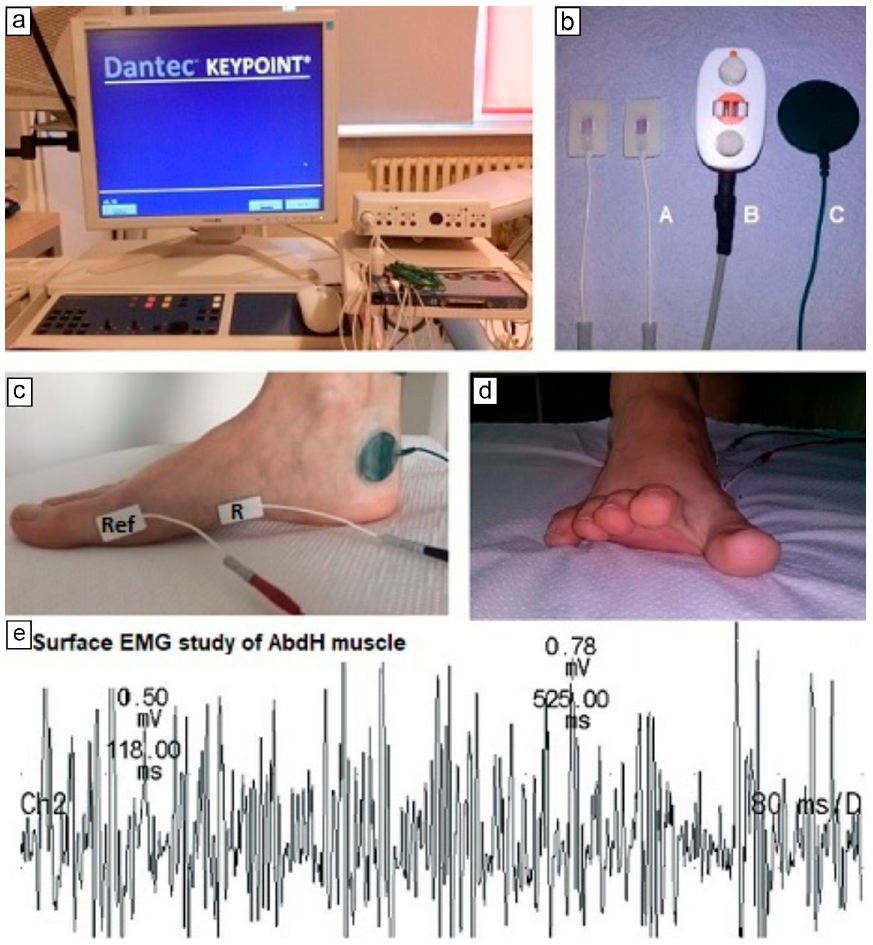
Figure 2. Surface EMG study of abductor hallucis muscle. ( a,b )—KeyPoint System and set of electrodes; ( c ) application of electrodes on the AbdH muscle (R—recording electrode, Ref—reference electrode) and ( d ) the third phase of TSO exercises and ( e ) recording of AbdH muscle activity during maximal contraction.